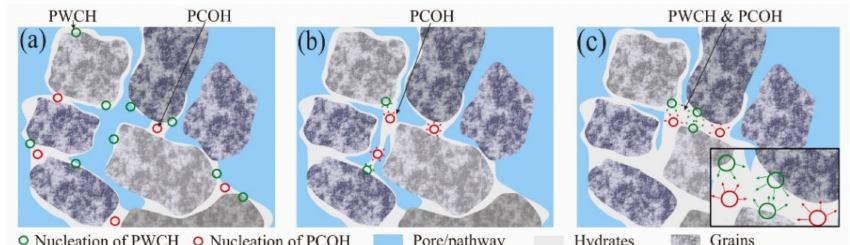
Figure 31. Hybrid growth habit of hydrate in pore spaces reprinted from [72] with permission from Elsevier. ( a ) Low hydrate saturation stage; ( b ) middle hydrate saturation stage; ( c ) high hydrate saturation